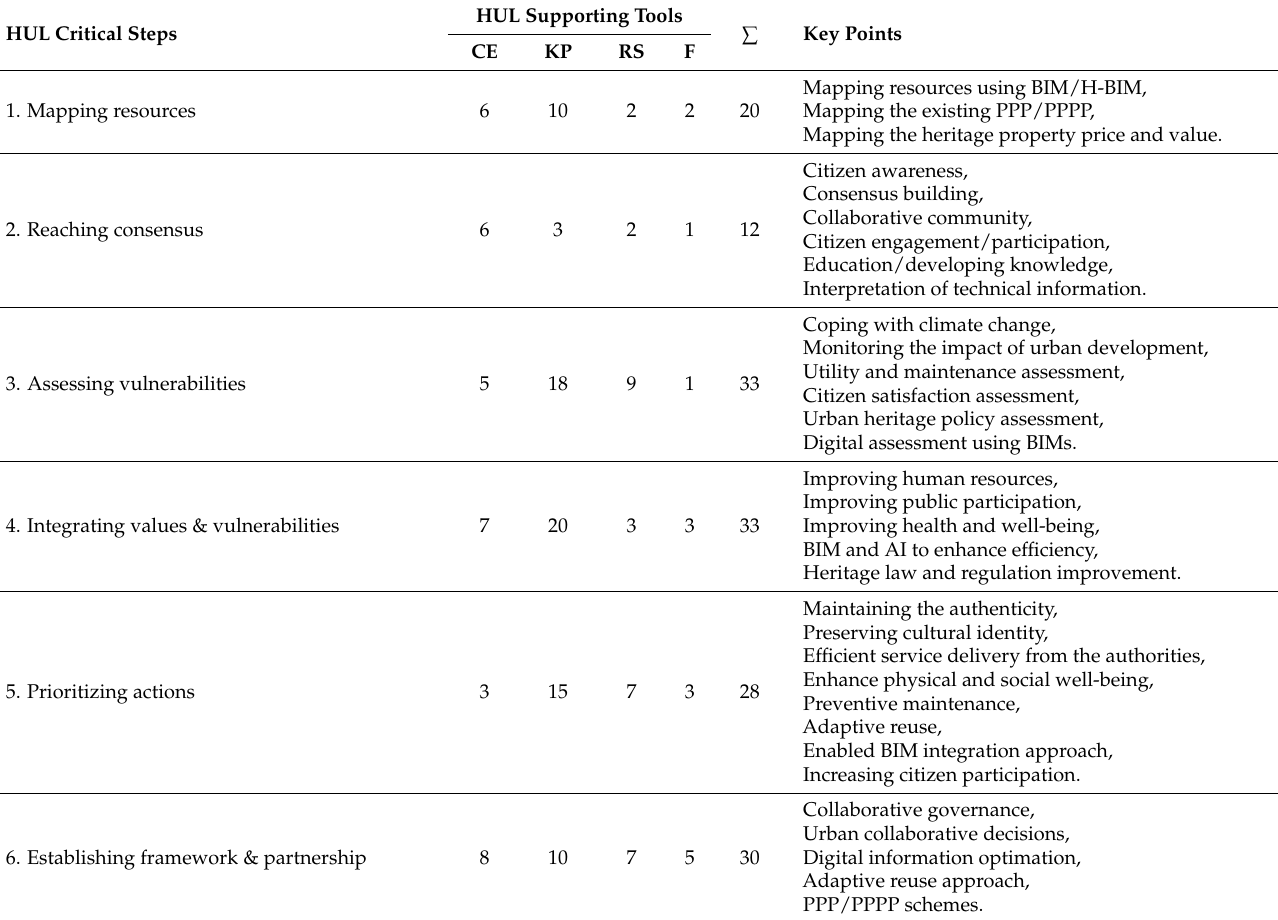
Table 7. Overall representation showing cross-cutting themes and concepts between urban FM and the HUL approach within the examined papers of scoping review, key points, and the number of studies on each HUL step. HUL Critical Steps